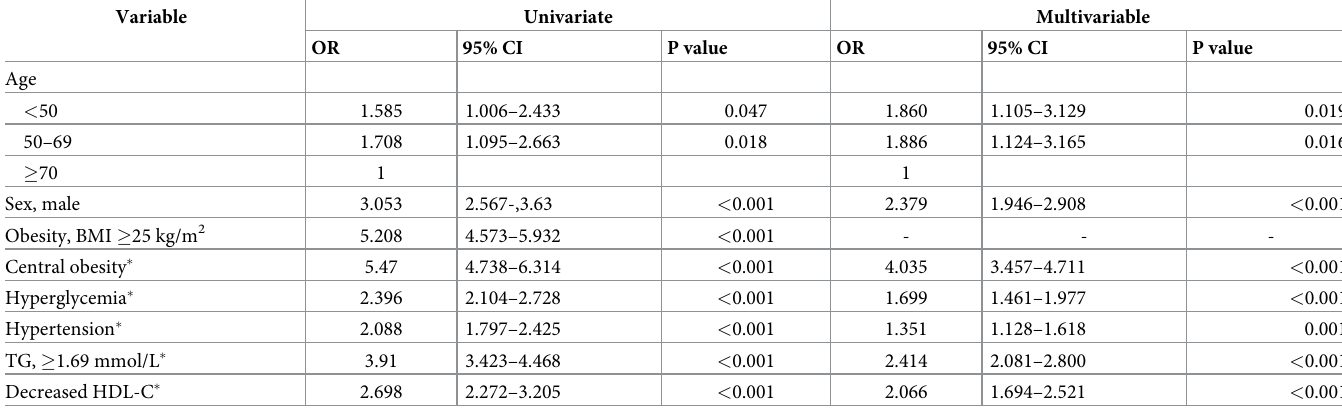
Table 2. Factors associated with fatty liver.